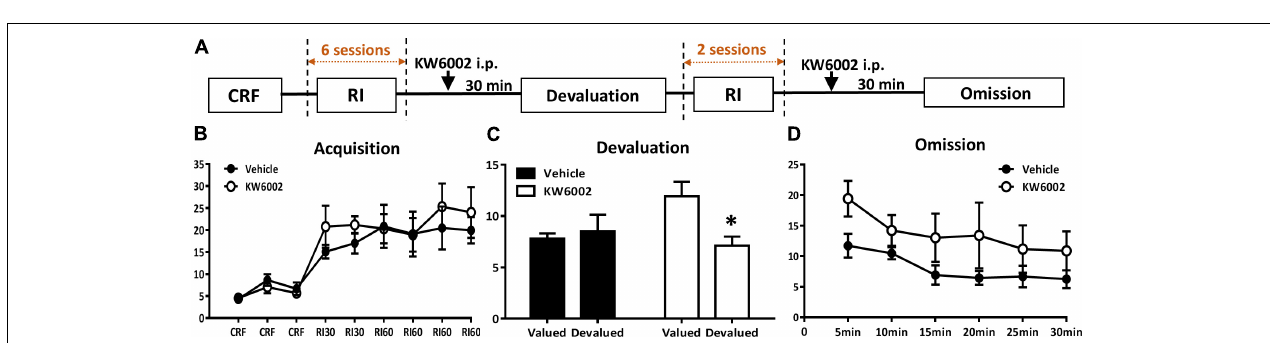
FIGURE 3 | Pharmacological blockade of A 2A Rs specifically in the expression phase of instrumental conditioning selectively promote goal-directed valuation but not action-outcome contingency. (A) Experimental design schematic with KW6002 injected intraperitoneally in the expression phase (i.e., devaluation and omission test) of instrumental behavior but not available in the training sessions. (B) Mice established instrumental conditioning indistinctively in the acquisition phase without between pre-manipulation groups effect ( p = 0.541) and interaction effect of training sessions X pre-manipulation groups ( p = 0.608). (C) KW6002 5 mg/kg or vehicle was administered 30 min before reward/home chow condition (i.e., devalued/valued condition). After 1-h exposure to devalued/valued condition at liberty, the devaluation test was proceeded in which reward delivery was absent and lever presses was recorded. Mice with KW6002 injected performed more goal-directed ( p = 0.017, ∗ p < 0.05), compared to that injected with vehicle ( p = 0.710). (D) After 2-day extended RI60 training sessions, KW6002 5 mg/kg or vehicle was injected 30 min before omission test. Mice of both groups significant decreased their lever presses (time main effect, p = 0.020). But there was neither between-subject effect of drug treatments ( p = 0.089) nor drug treatments X testing time interaction effect ( p = 0.728). All data was analyzed by two-way ANOVA for repeated measurement, followed by post hoc comparison with Bonferroni test (vehicle group, n = 8; KW6002 group, n = 7).